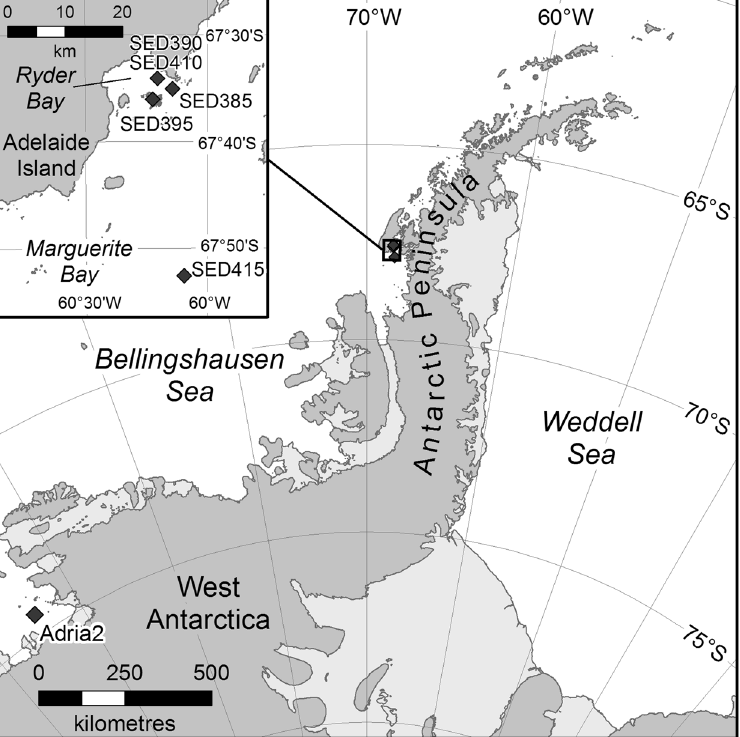
Figure 5. Map showing the main sampling sites along the Antarctic Peninsula, with finer detail of the deep- water sites in Ryder Bay. SED 385 is closest to Rothera Research Station and the sites of the four shallow-water sediment-sampling sites (not shown at this scale). Maps made in-house at BAS using ArcGIS v10.1 by the Mapping and Geographical Information Centre